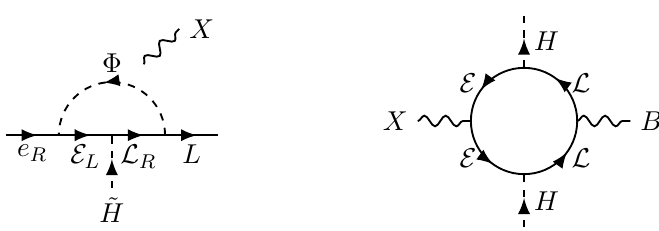
Figure 2 . Representative diagrams leading to the generation of the kinetic mixing and dark dipole moments at the one-loop level in the model of eq. (2.5). See the main text for more details.